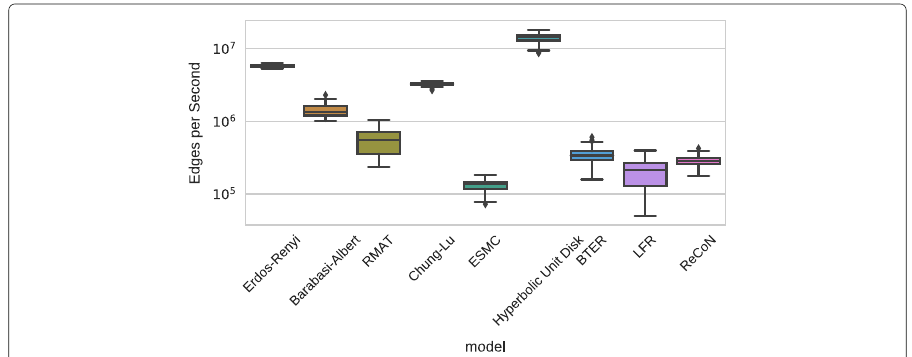
Fig. 6 Fitting and generating: processing speed measured in edges per second (size of replica graph/total running time, measured on 100 Facebook graphs)